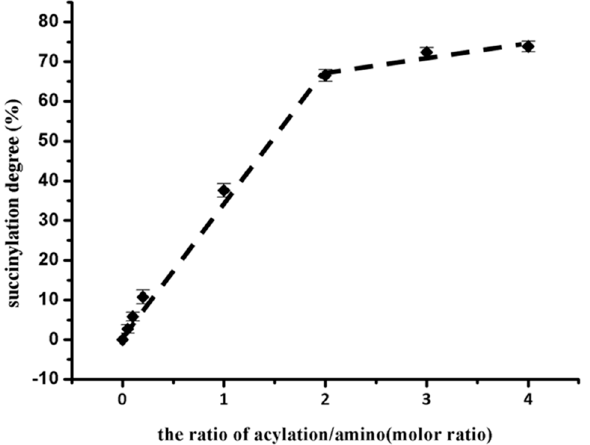
Figure 1. The relationship between the succinylation degree and various anhydrides: amino group molar molar ratios.